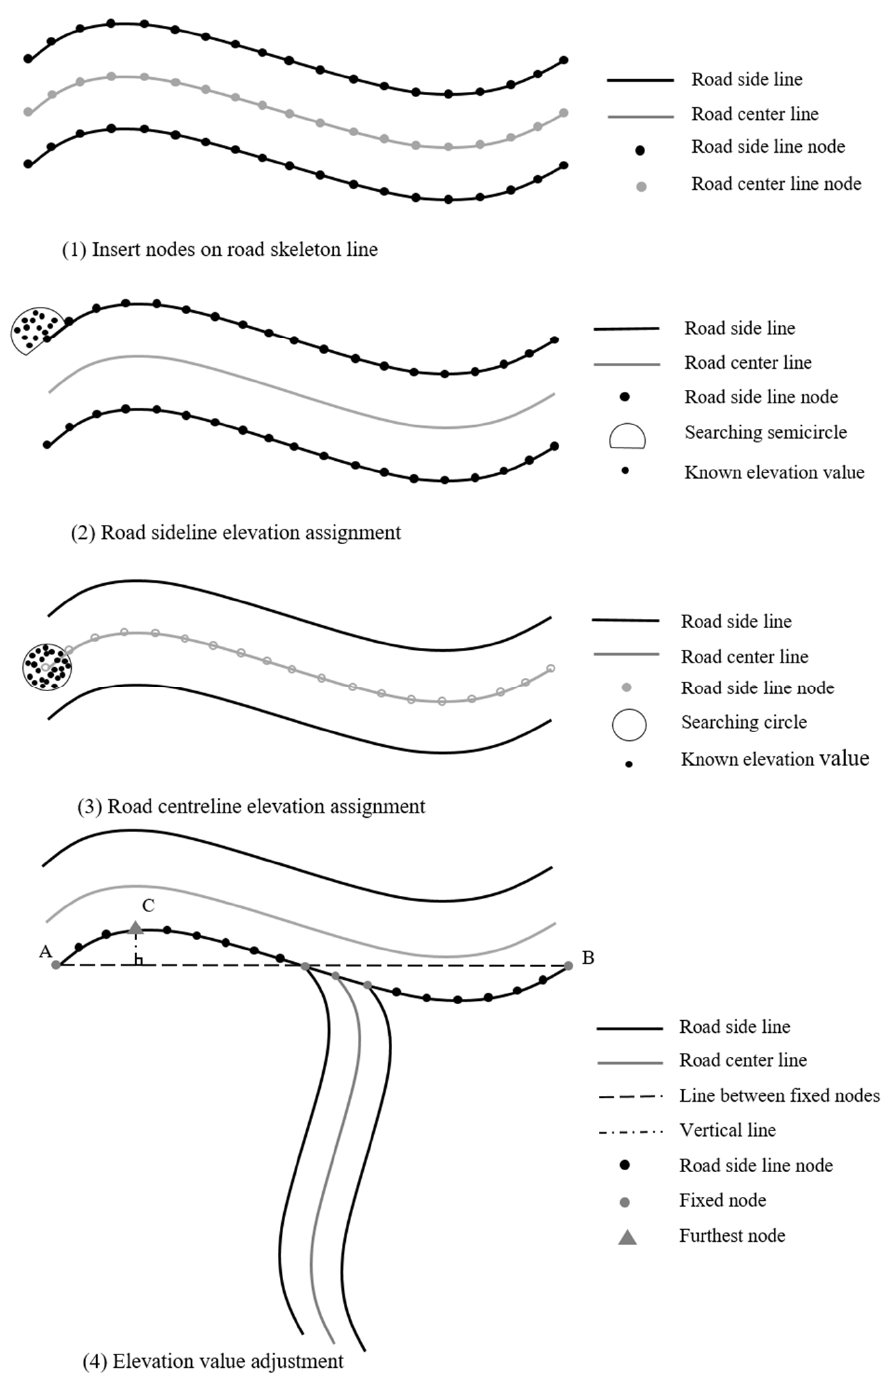
Figure 3. Elevation assignment process of the road skeleton line.